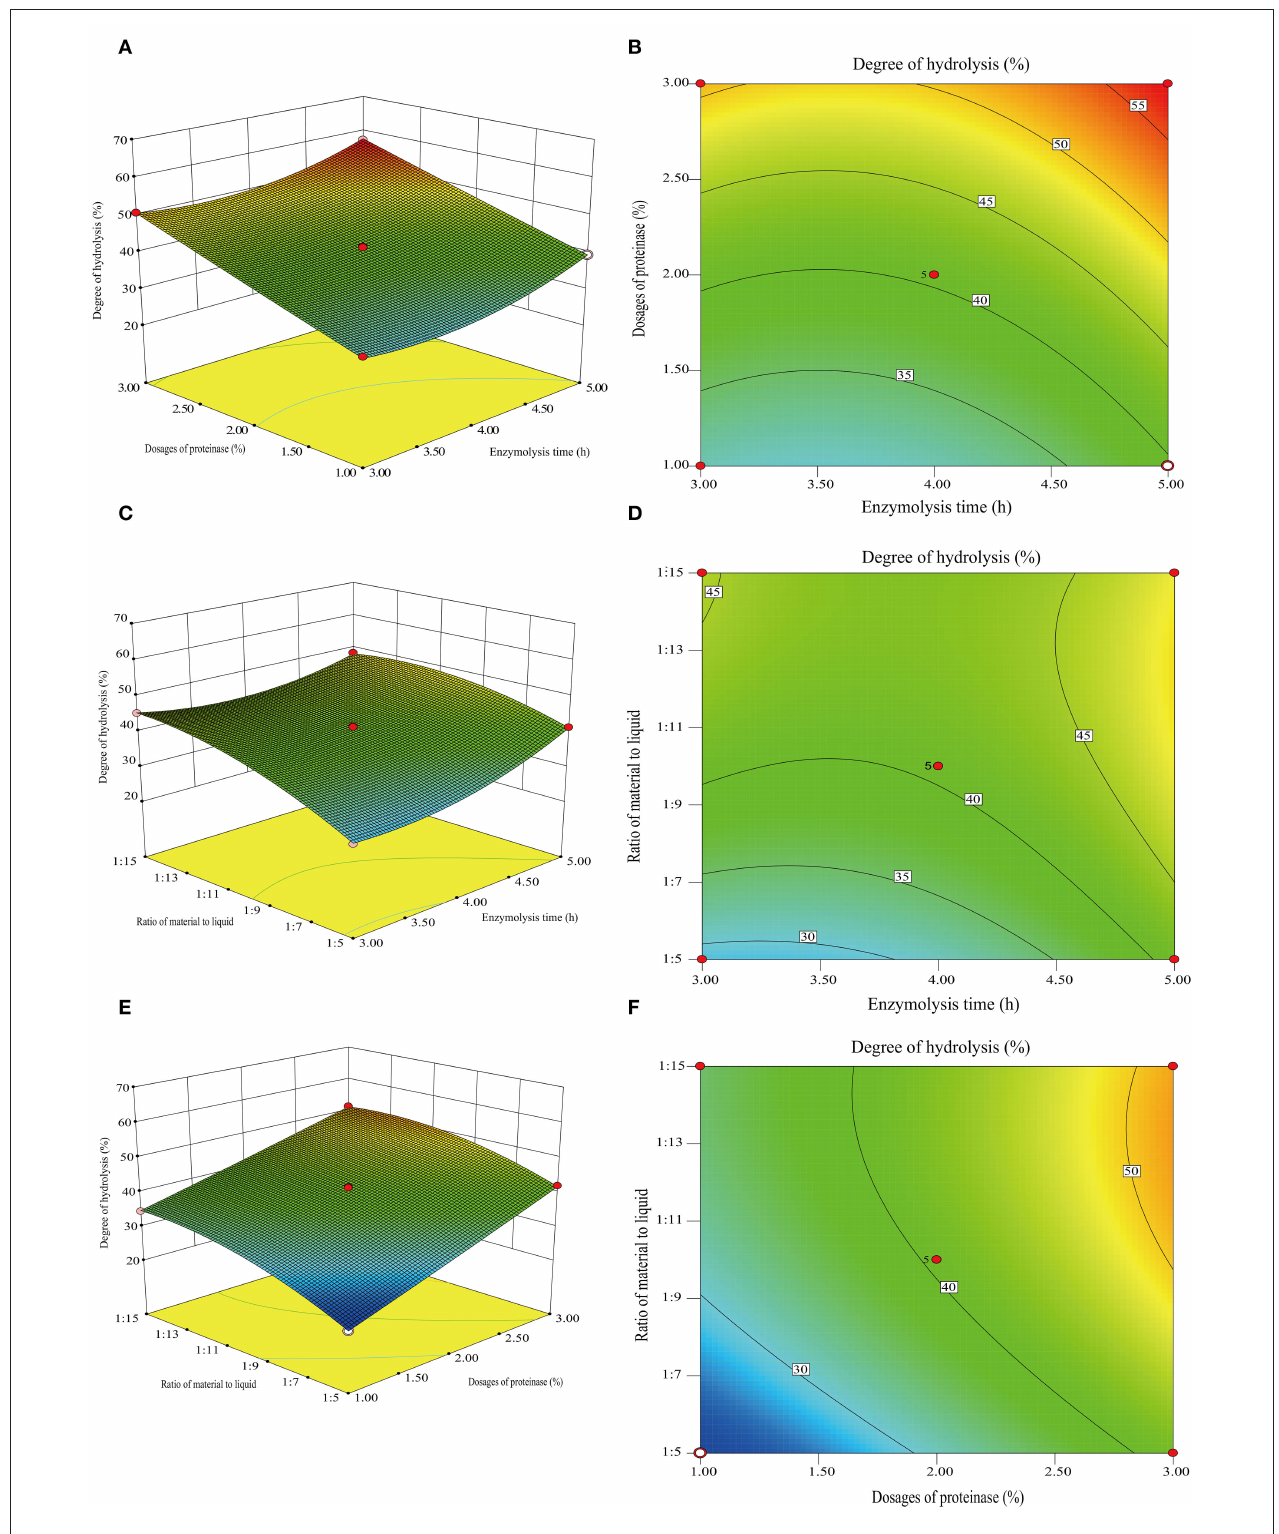
FIGURE 4 | 3D response surface plots and 2D contour of the interactive effects on the degree of hydrolysis. Dosages of proteinase and enzymolysis time (A,B) , the ratio of material to liquid and enzymolysis time (C,D) , and the ratio for material and liquid (E,F) .